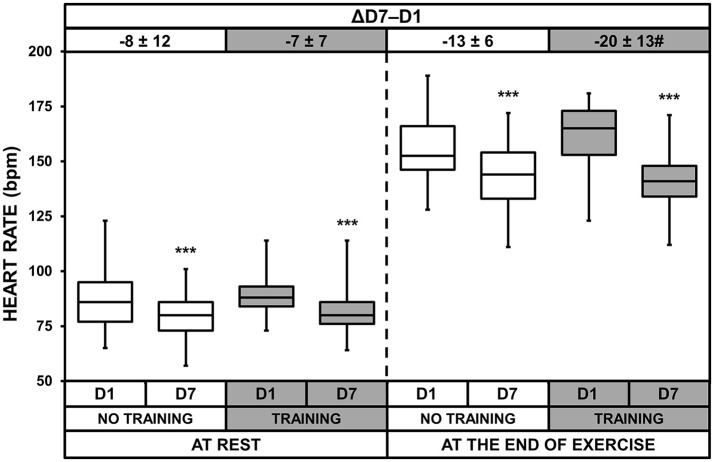
Box-and-whisker plots for heart rates of the No Training and Training groups before (D1) and after (D7) heat acclimatization, at rest and at the end of exercise. The box encompasses the 25–75% quartiles, and the median is represented by the horizontal line within the box. The whiskers extend to the highest and lowest values. Values shown above the boxes, at the top of the plot, correspond to the differences (mean ± SD) between D7 and D1. Significantly different from D1, ***p < 0.001; ΔD7-D1 significantly different from NT group, #p < 0.05.